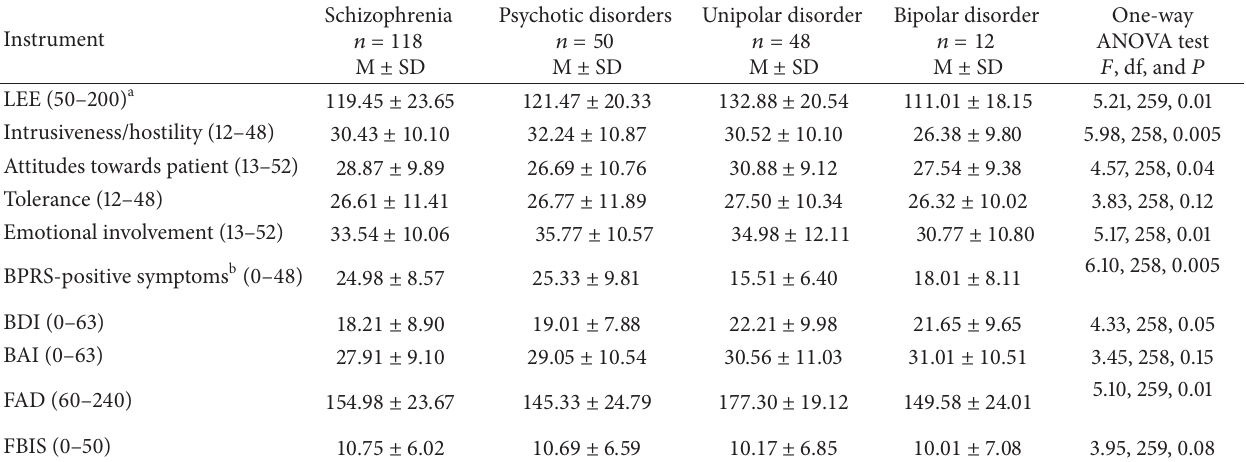
Table 6: Levels of perceived expressed emotion and other psychological measures in patients with different psychiatric diagnoses.